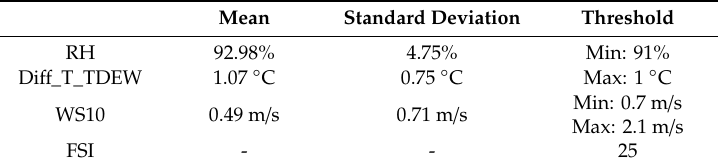
Figure 10. Histograms of the measurements of ( a ) relative humidity, ( b ) surface temperature/dew point difference, ( c ) wind speed in fog condition at Ferrara in the period January 2011–December 2017 and ( d ) ROC curve obtained with FSI_thresh = 25. Table 11. Mean, standard deviation and thresholds selected for relative humidity, surface temperature / dew point depression and wind speed measured in fog condition and FSI threshold calculated using Youden’s index for Ferrara.